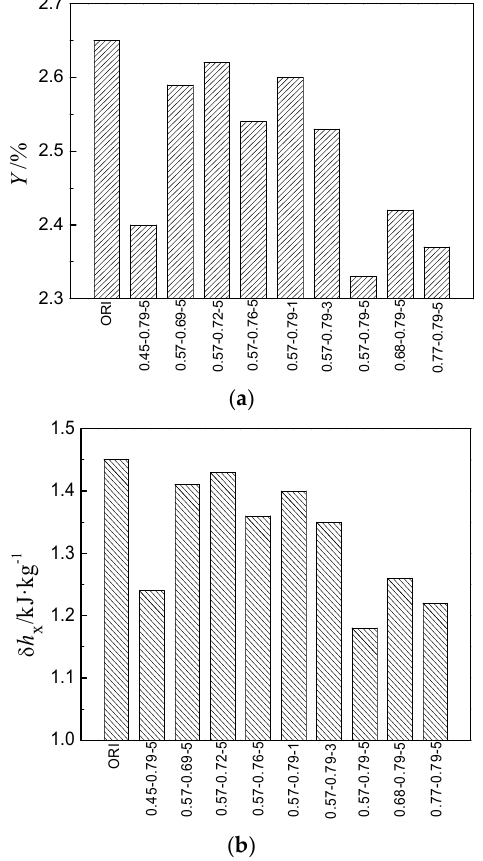
Figure 12. Comparison of comprehensive performance of ( a ) wetness and ( b ) wetness losses of cascade